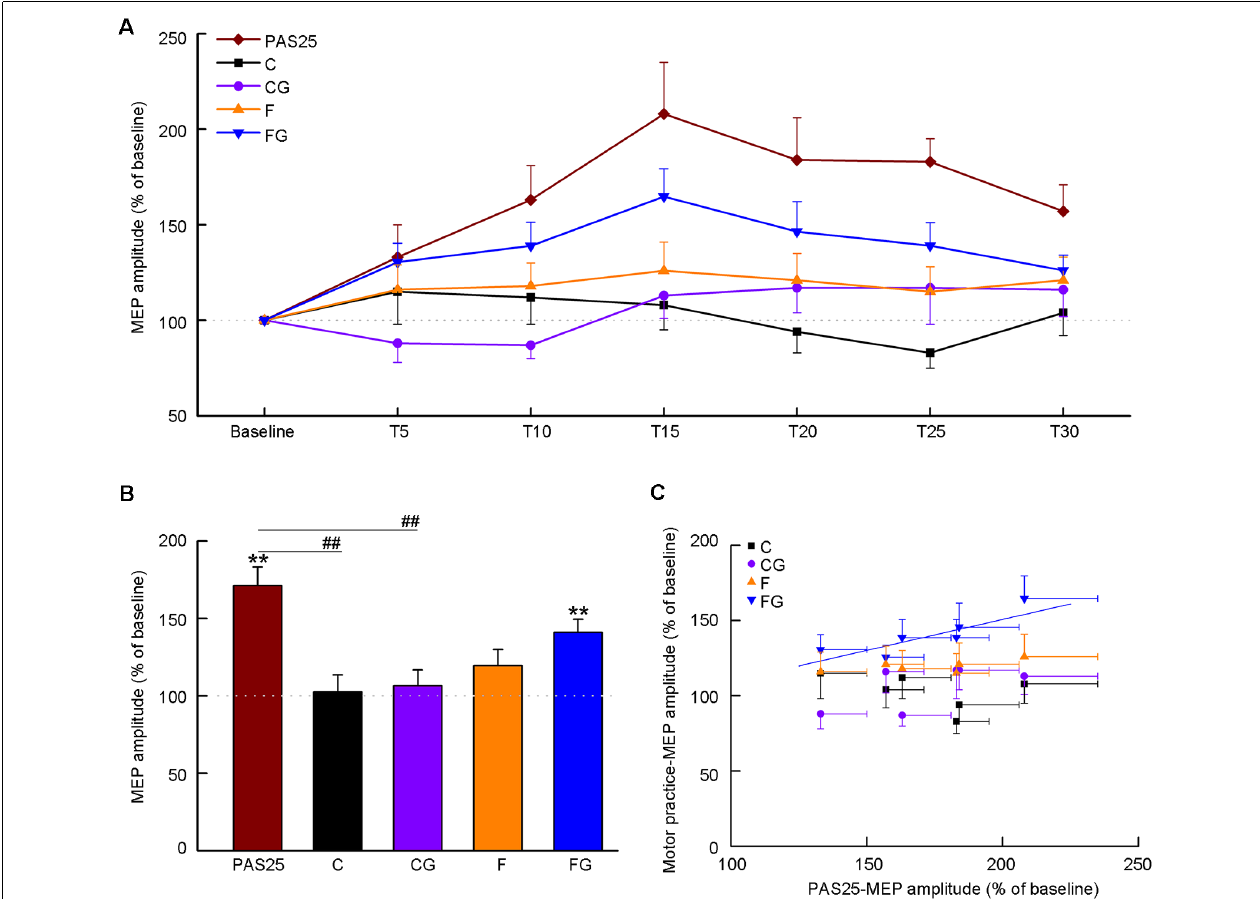
FIGURE 3 | Effects of interventions on motor-evoked potential (MEP) amplitude. Data obtained from 15 subjects. The coordinate indicates the MEP amplitude normalized as a percentage value to baseline tested before the intervention. (A) Time course of MEP amplitude before and after five interventions. The abscissa indicates the time from baseline to 30 min after interventions. (B) Average MEP amplitude after interventions. (C) Correlation between PAS25 and motor tasks. The abscissa indicates the average MEP amplitude at six-time points (5, 10, 15, 20, 25, 30 min) after PAS25. Solid lines represent the significant correlation between normalized MEPs only after PAS25 and FG. All the symbols are mean ± SD for both x and y values. ** P < 0.01, compared with baseline (100%). ## P < 0.01, PAS25 vs.